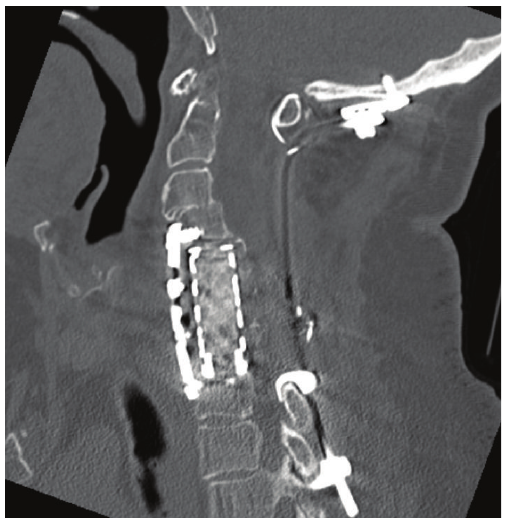
Figure 6: Occipitocervical fixation supplemented by vertebrectomy with an anterior cage and plate fixation for a patient who required decompressive cervical